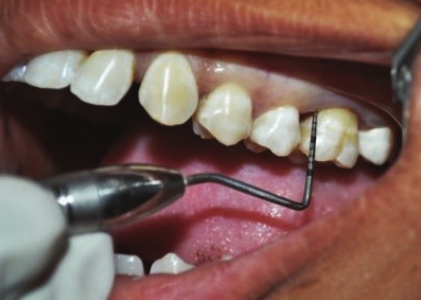
Figure 2: Manual probing alone in one randomized quadrant.